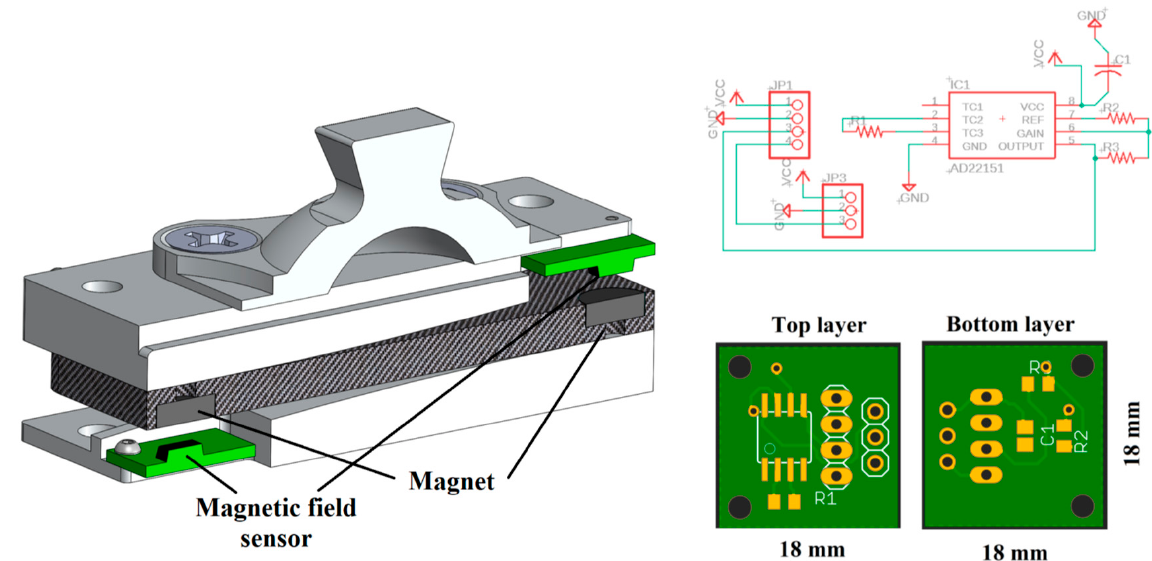
Figure 6. Section view of the FM-PLS showing placement of electrical component and magnet ( left ); The electrical circuit diagram ( top right ) and custom-printed circuit board ( bottom right ).